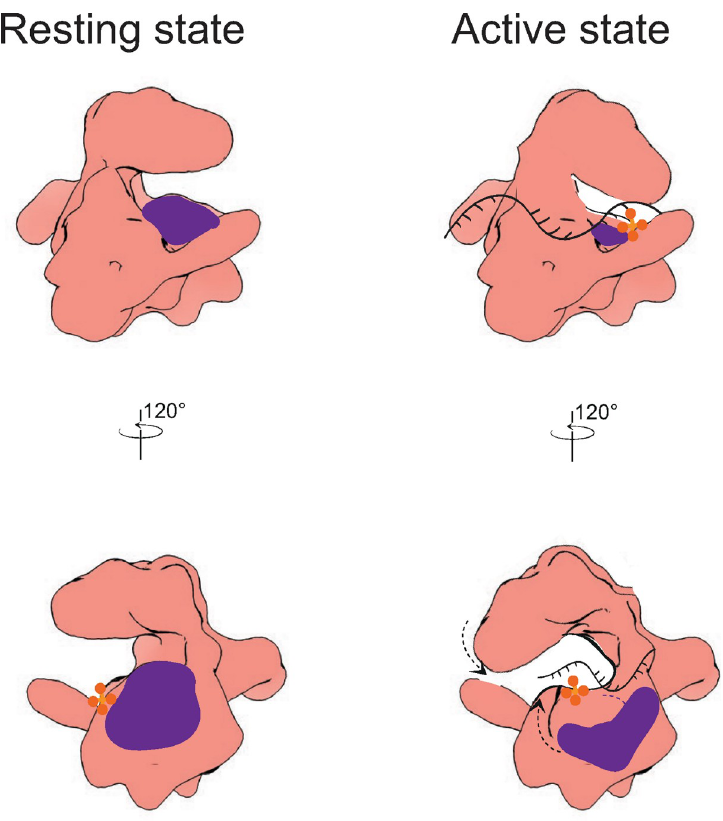
Fig 7. A speculative mechanism of Chl1 auto-inhibition. In its inhibited state, access to the DNA-binding site is restricted by the insert (purple) sitting in HD1. By binding of an interacting partner, structural rearrangements within the protein lead to movement of the insert away from the DNA binding cleft. As a consequence, DNA can be engaged and the Arch domain can adopt a more closed